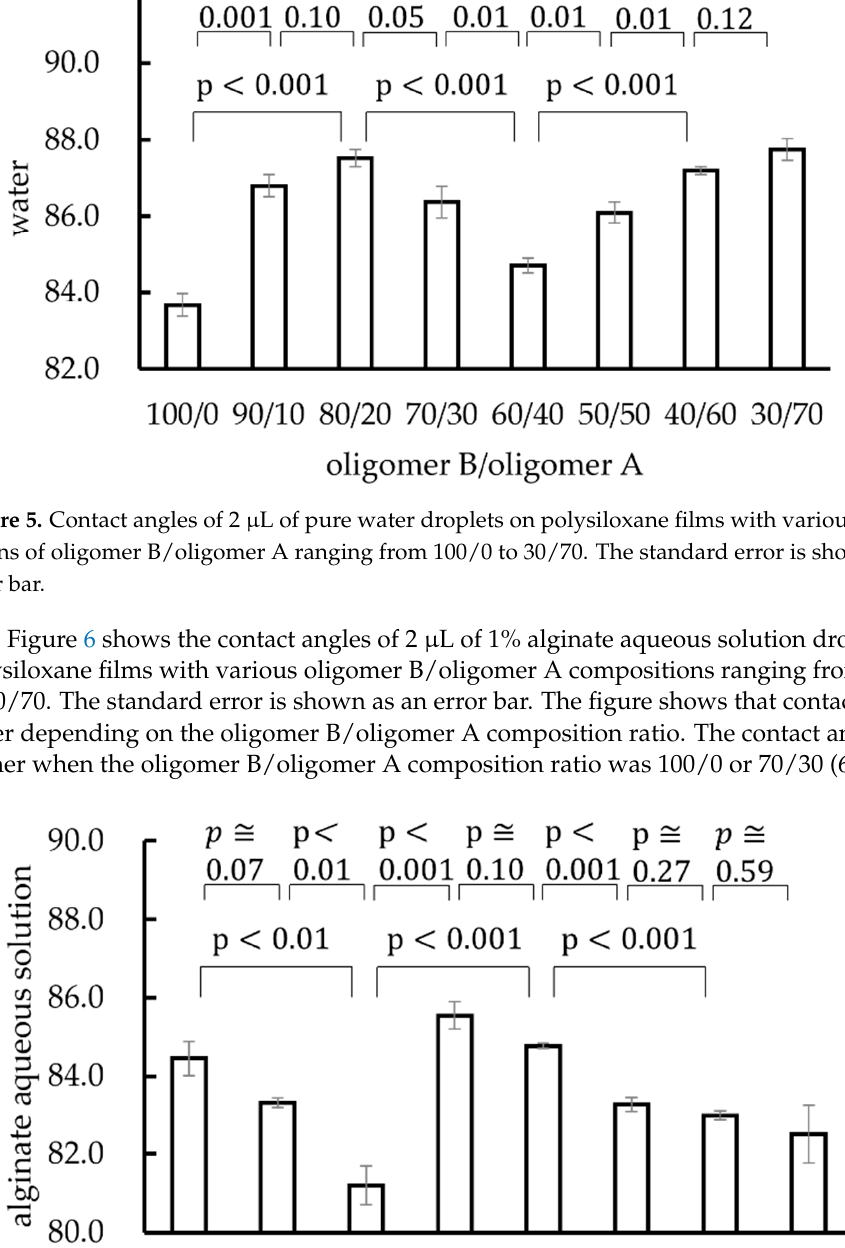
Figure 6. Contact angles of 2 µL of 1% alginate aqueous solution droplets on polysiloxane films with various compositions of oligomer B/oligomer A ranging from 100/0 to 30/70. The standard error is shown as an error bar.